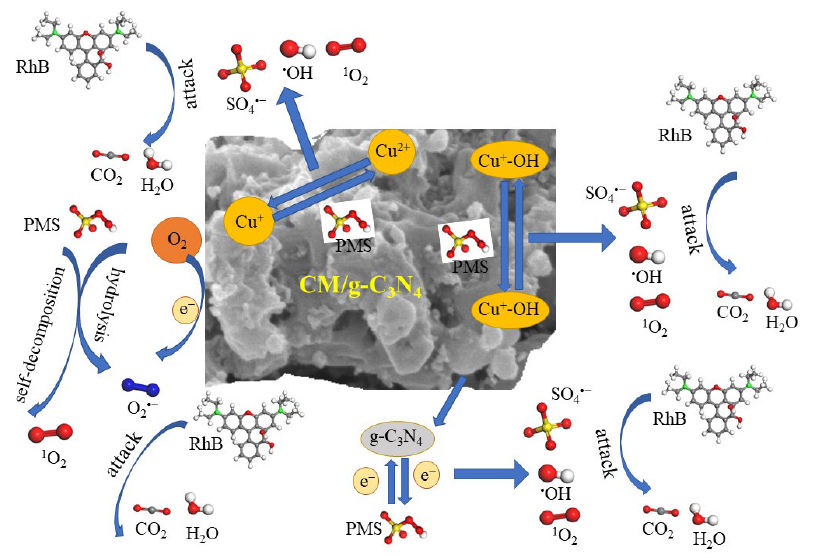
Scheme 1. The possible activation mechanism of